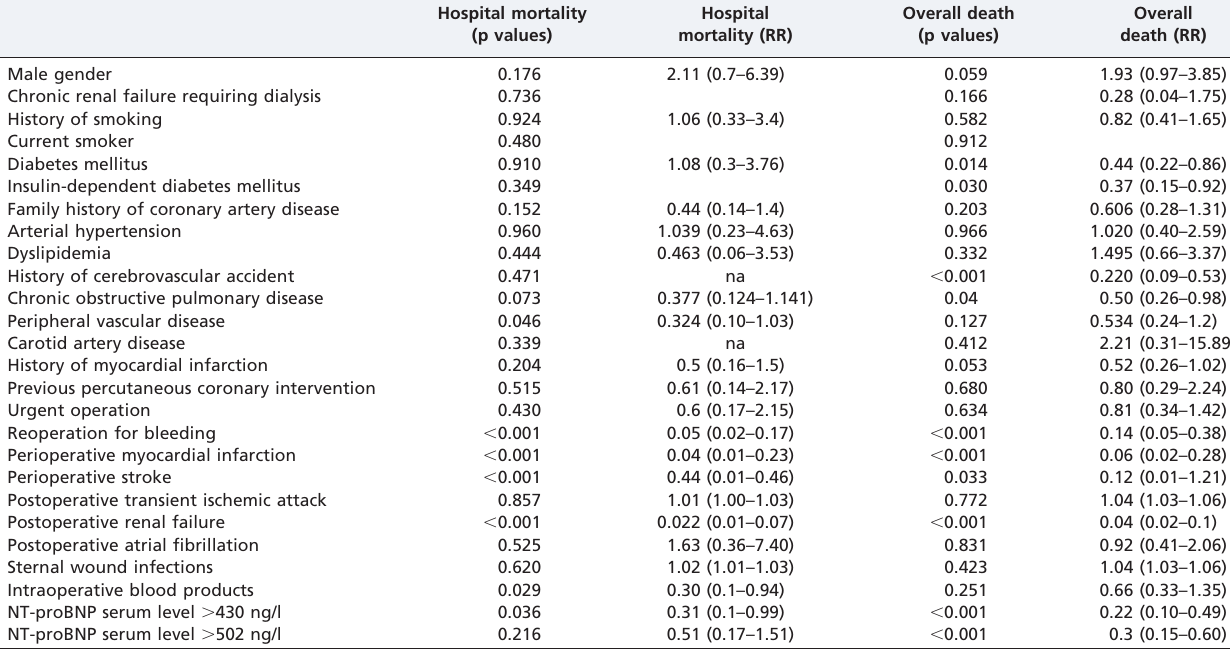
Hospital mortality Hospital Overall death Overall (p values) mortality (RR) (p values) death (RR)